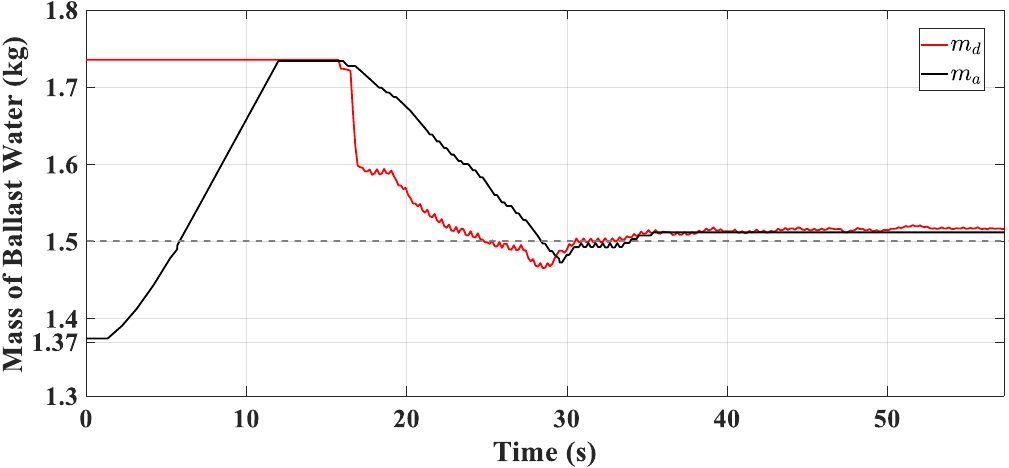
Figure 16. Demanded and actual ballast mass changes of depth control via on-off type VBS.